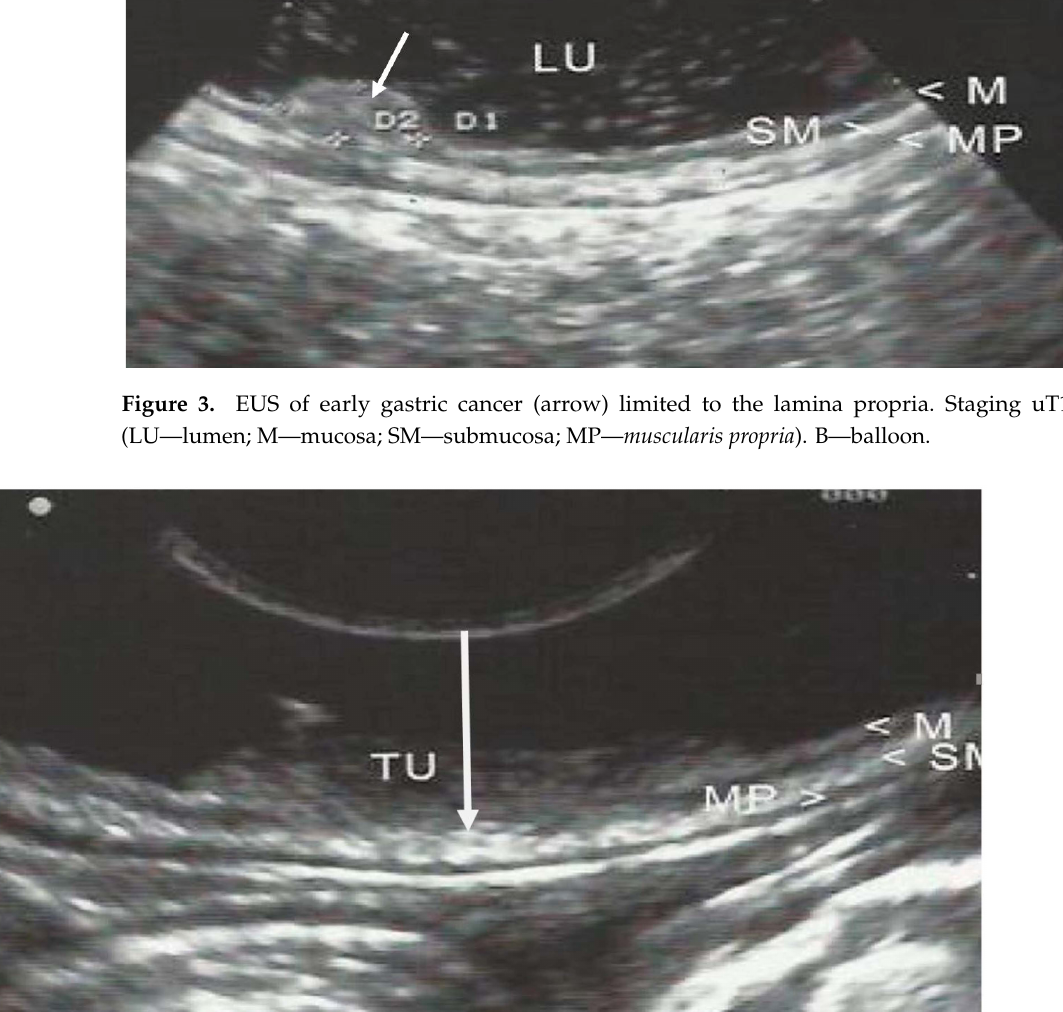
Figure 4. EUS image of early gastric cancer with shallow infiltration (arrow) of the submucosal tissue (staging sm1). (M—mucosa; SM—submucosa; MP— muscularis propria ;